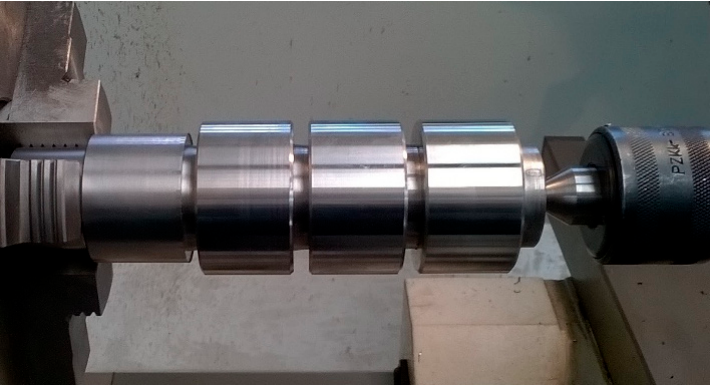
Figure 3. The shaft used in research.